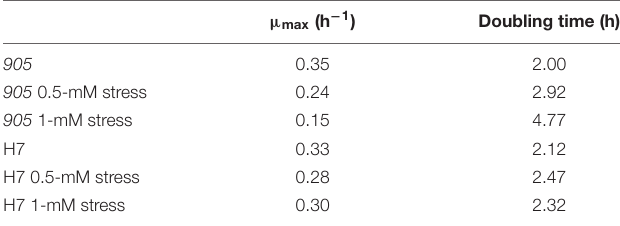
TABLE 1 | Maximum specific growth rates ( µ max “h − 1 ”) and doubling times (h) of the reference strain (905) and the evolved strain (H7) in the absence and presence of 0.5-mM and 1-mM H 2 O 2 stress.